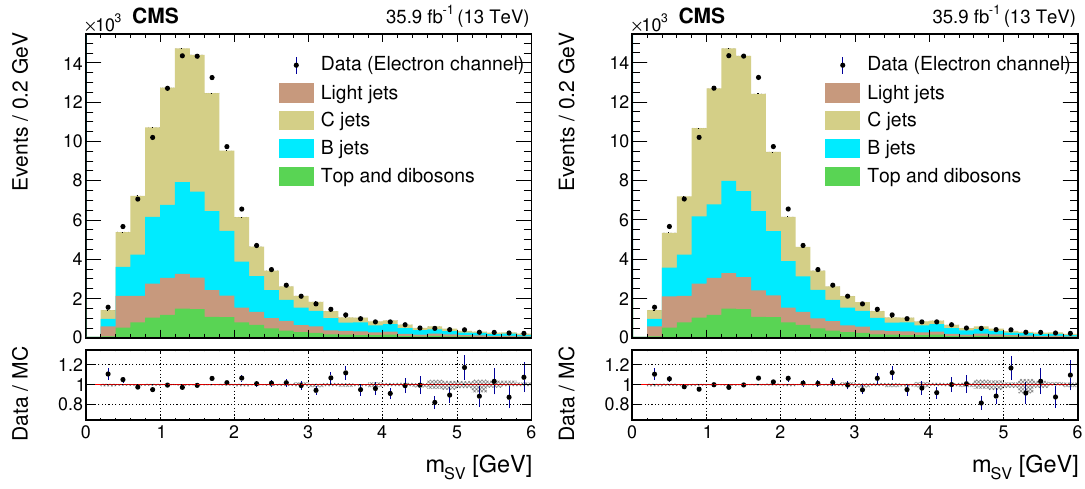
of the highest- p c -tagged central jet, for SV T (left) and c -tagged central jet T